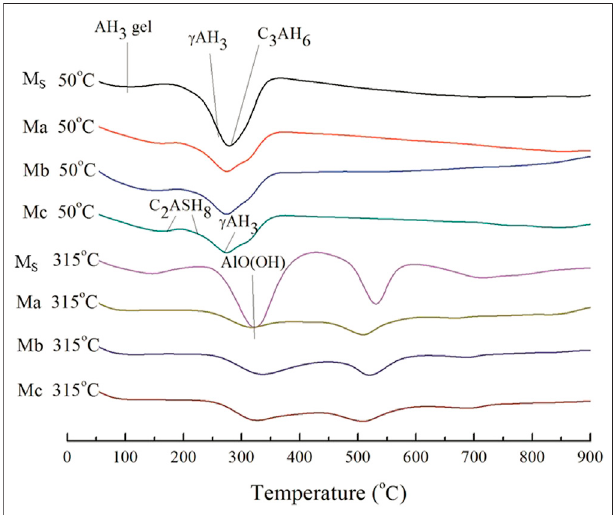
FIGURE 5 | DSC thermograms of CAC pastes.